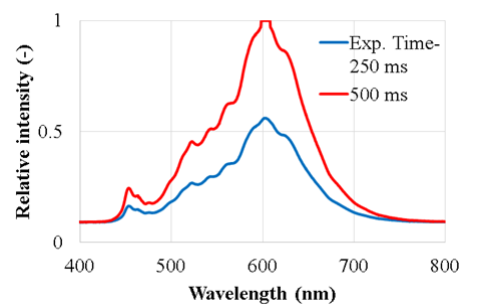
Fig. 4. Characteristic of the used diode with different time of the